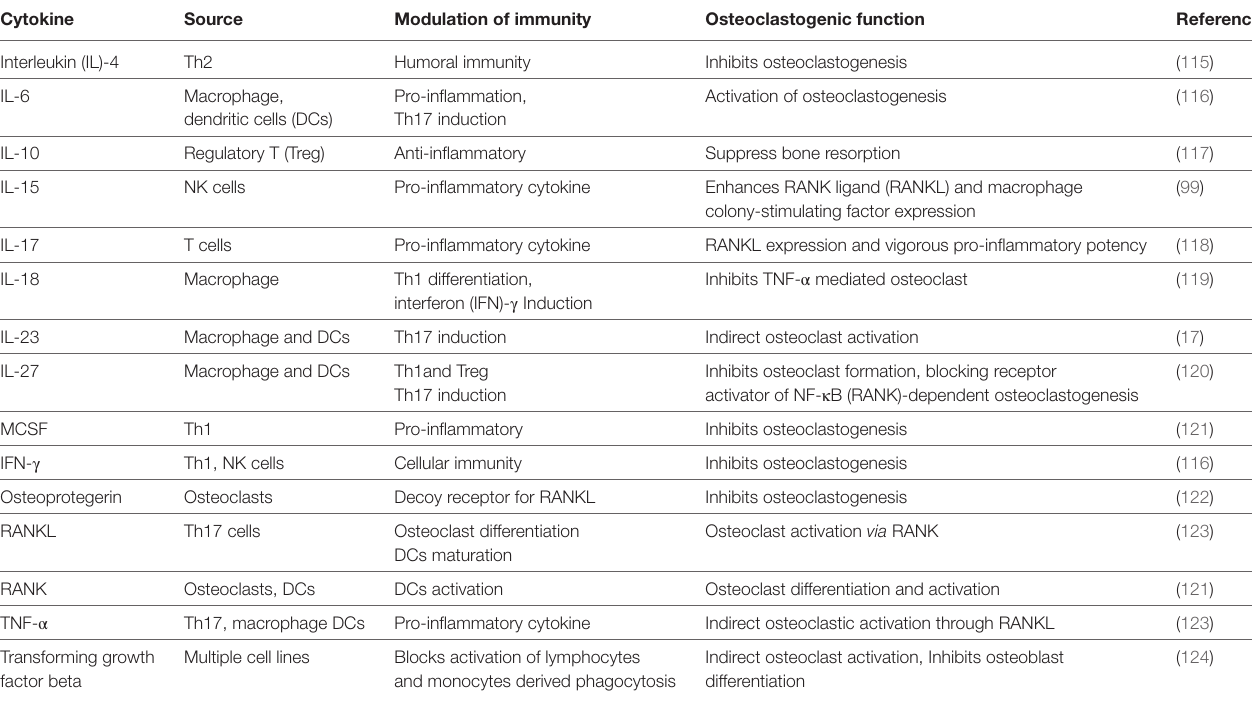
TABLe 1 | Role of various T cell cytokines in